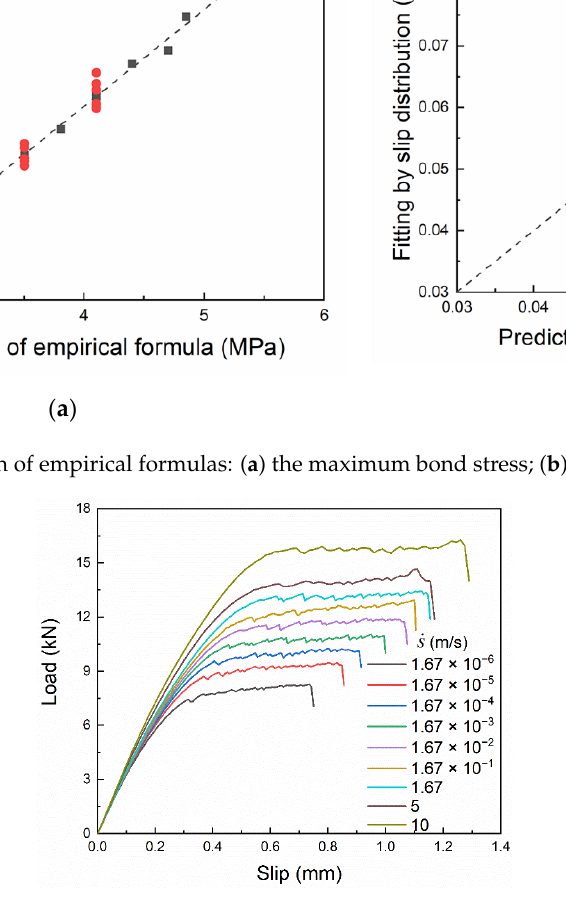
Figure 24. Load–slip curves under different slip rates.